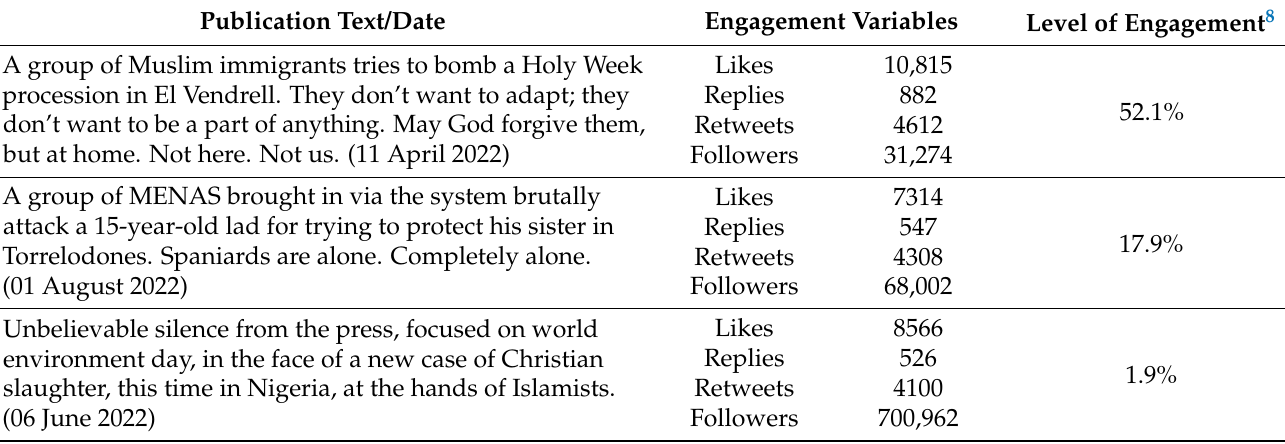
Table 2. Engagement rate of the most viral publications (retweets) by Vox (@vox_es) that concern Islam and/or Muslims in 2022.